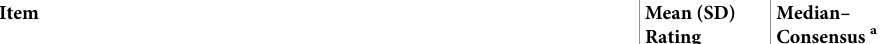
Table 2. Items on the benefits and harms of open notes in mental healthcare that reached